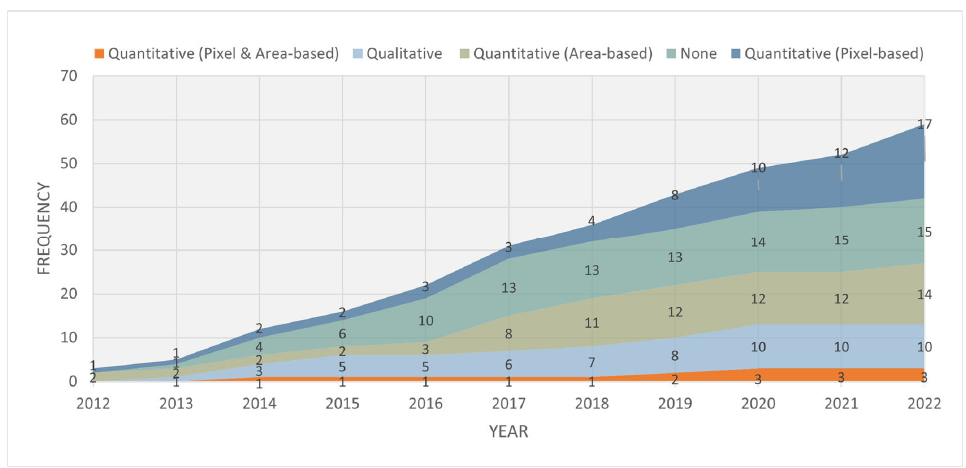
Geomatics 2023 , 3 Figure 9. Trend analysis of the validation methods reported in the selected articles.